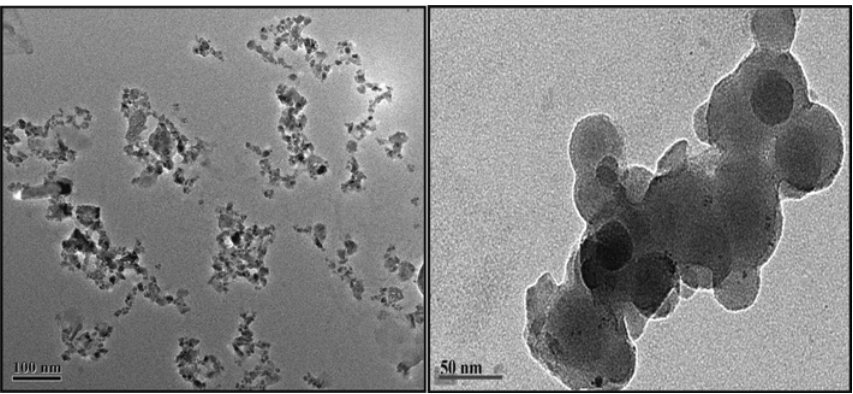
Figure 4: Transmission electron microscopy images of iron oxide nanoparticles.